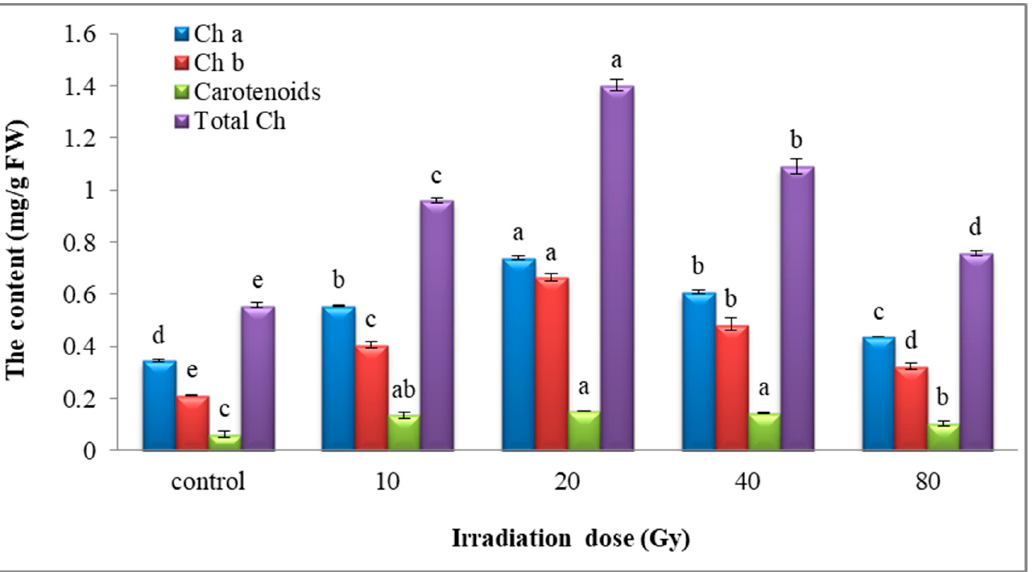
Figure 2. Photosynthetic pigment contents (mg/g FW) of red radish plants affected by different doses of gamma-rays. Findings are mean ± standard deviations (n = 3). Different letters point to significant differences at p ≤ 0.05, and bars indicate standard deviations.